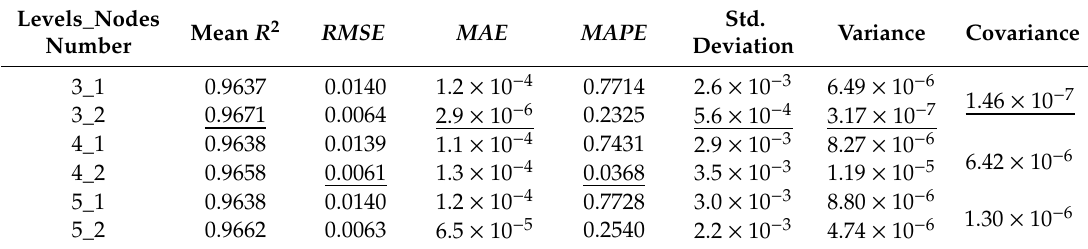
Table 6. Statistical results for the testing analysis of FCM